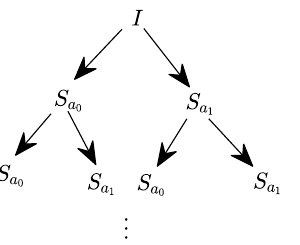
Figure 1. The binary tree structure of the multiple subdivision S a